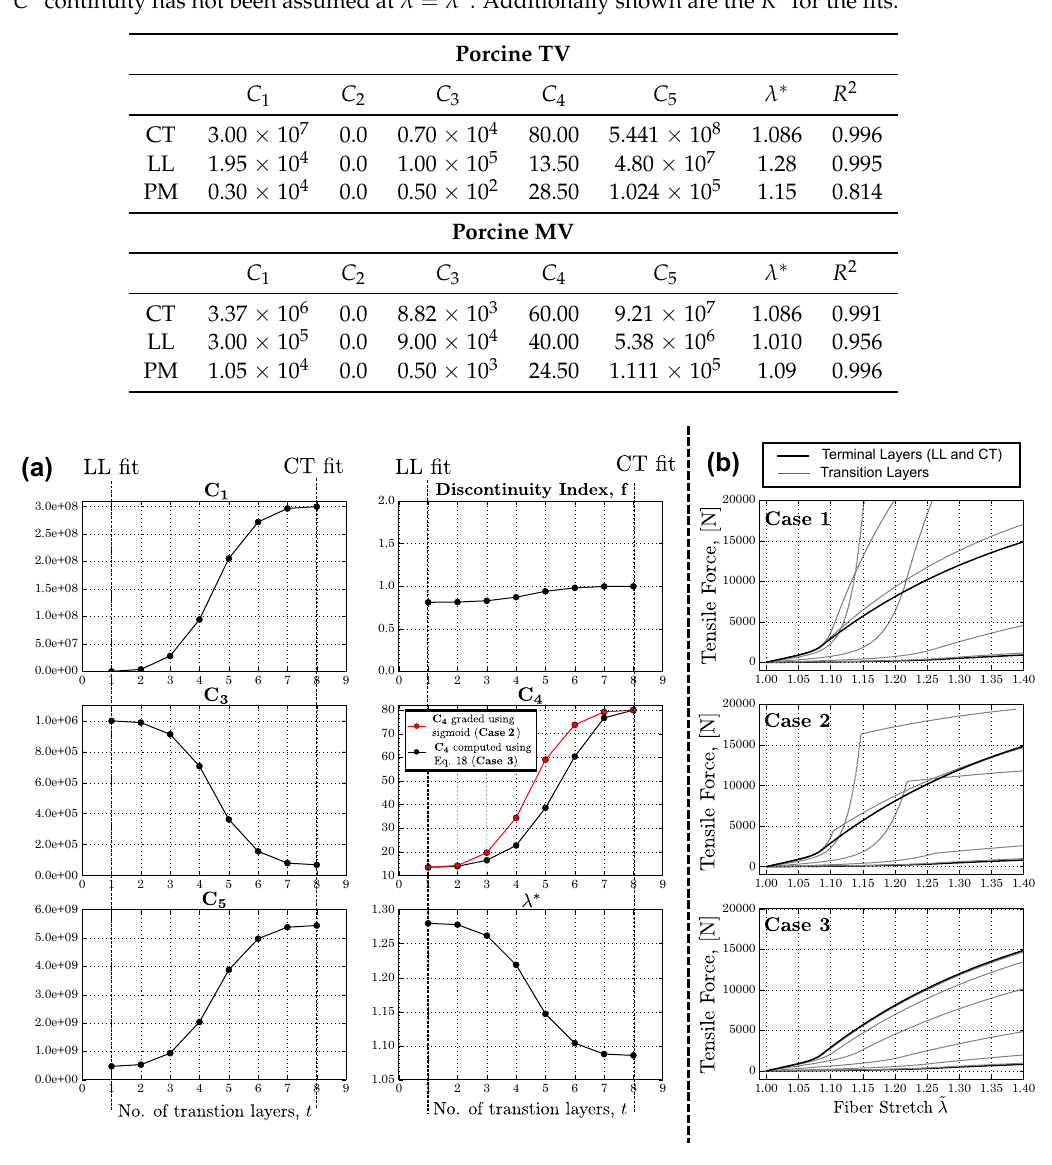
Figure 3. ( a ) Distribution of C 1 , f , C 3 , C 4 , C 5 and λ ∗ in the chordea tendinea–leaflet (CT–LL) transition region of TV using the interpolation law proposed in Algorithm 1, used for the uniaxial tension tests in Case 3. Additionally overlaid in the distribution for C 4 is the corresponding graded parameter using a sigmoidal function, shown in red, corresponding to the C 4 distribution for Case 2. ( b ) Tensile force in the unit cell along the fiber orientation for Cases